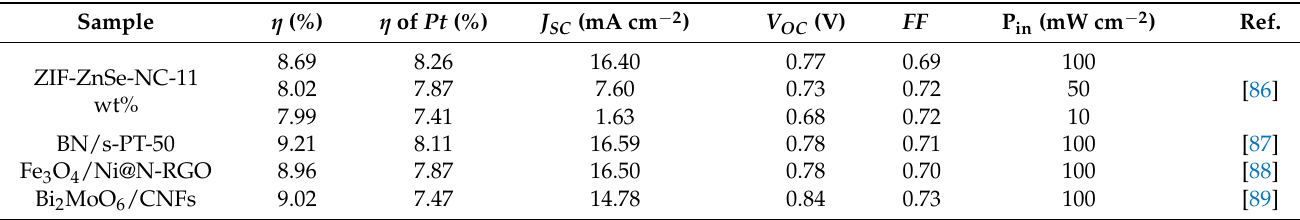
Table 7. The photovoltaic parameters of various conductive polymer material-based CEs in the DSSC with an I − /I 3 − redox couple and N719 dye are compared under simulated solar light conditions.